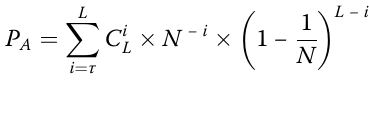
Table 1 The recommended value of L and τ for the trigger sets of N -classification networks N 2 5 10 100 The size of trigger set: L The threshold: